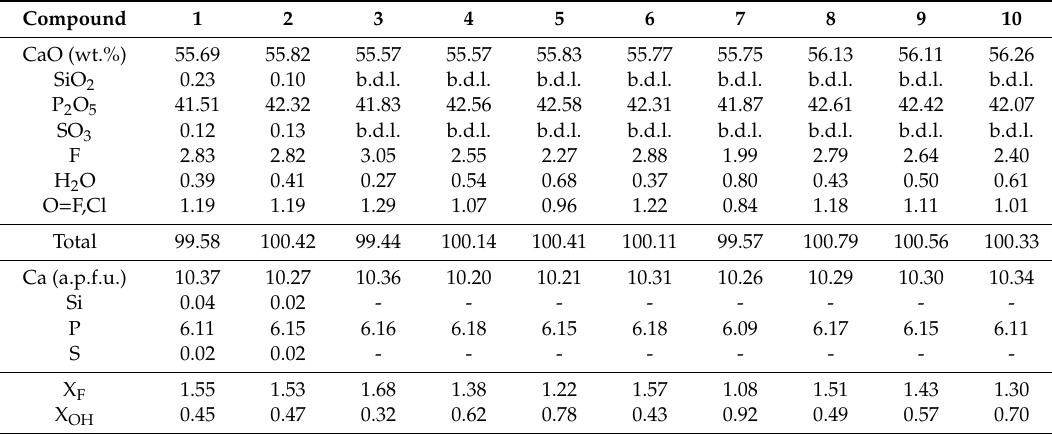
Table 1. Representative electron microprobe analyses (EMPA) of apatite and number of a.p.f.u. are calculated on the basis of 25 O 2 − of the investigated sample from the Kanarata quarry, Bulgaria.